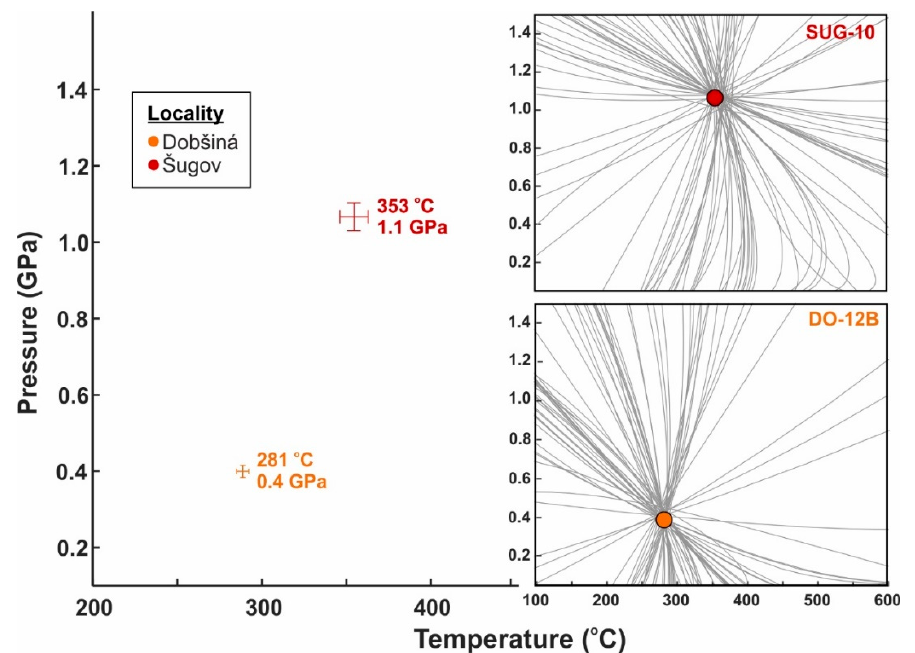
Figure27. P–TdiagramswithunivariantcurvesandpointsintersectingwithChl–Phpairsatequilibrium Figure 27. P–T diagrams with univariant curves and points intersecting with Chl–Ph pairs at P–T conditions 353 ◦ C at 1.1 GPa and 281 ◦ C at 0.4 GPa. B ô rka Unit diagrams were created by MATLAB equilibrium P–T conditions 353 ° C at 1.1 GPa and 281 ° C at 0.4 GPa. Bôrka Unit diagrams were created script provided by [43]. Crosses represent Chl–Ph pairs equilibrium by MATLAB script provided by [ 43 ]. Crosses represent Chl–Ph pairs equilibrium tolerance.